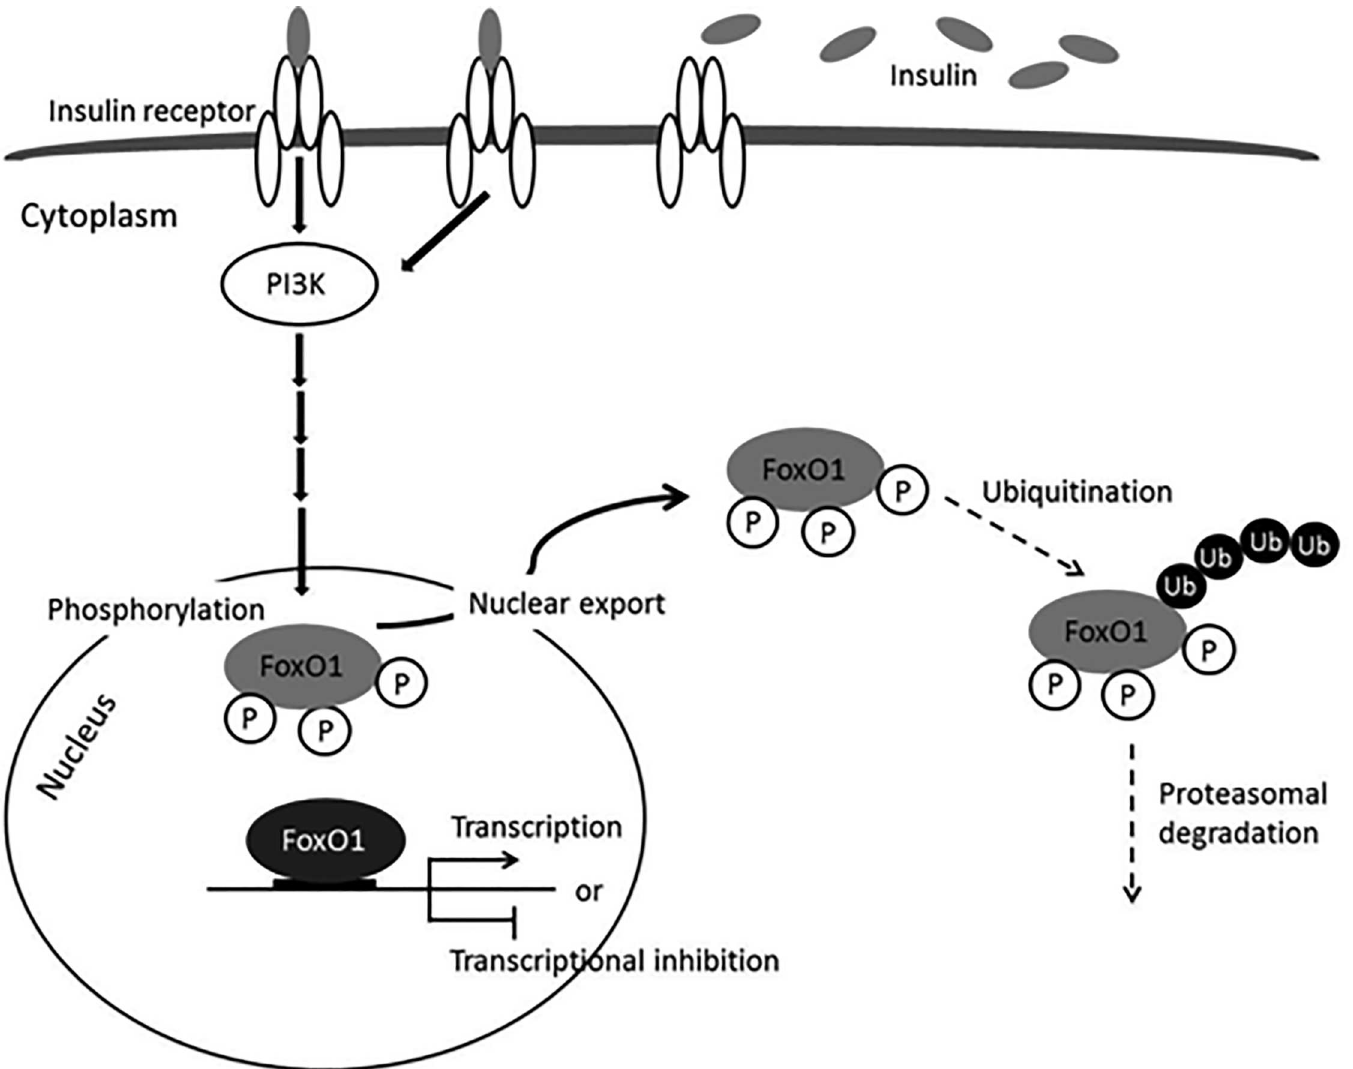
Fig 5. A model on FOXO1 regulation via insulin-induced phosphorylation-dependent degradation. A model on FOXO1 regulationthrough insulin- inducedphosphorylation-dependentdegradationas suggestedin some other cell types: PI3K is activated by insulin,the FOXO proteins are phosphorylated, resultingin their transcriptional inactivationthrough their nuclear export and cytoplasmic retention followedby a multistep negativeregulationincluding ubiquitination and proteasomal degradation